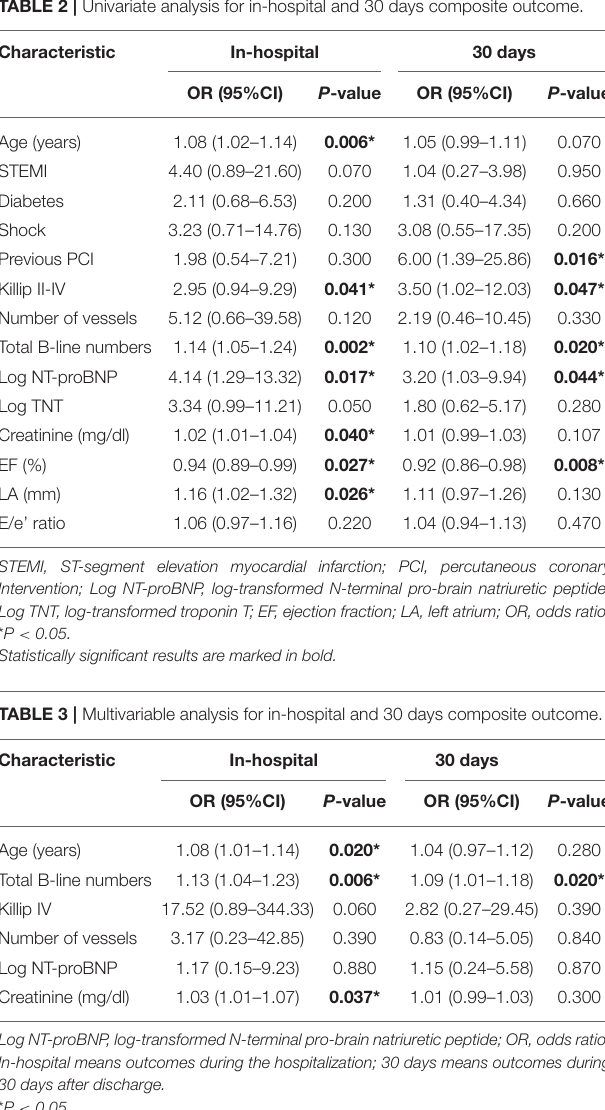
Log NT-proBNP, log-transformed N-terminal pro-brain natriuretic peptide; OR, oddsratio; In-hospital means outcomes during the hospitalization; 30 days means outcomes during 30 days after discharge. * P <